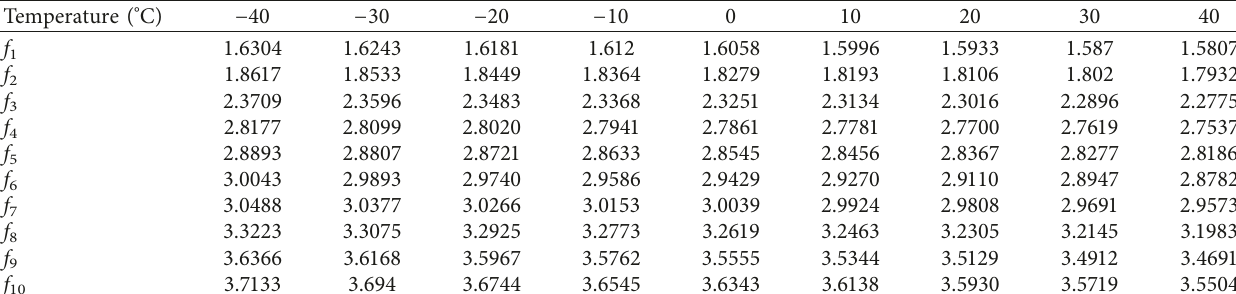
Table 2: Frequencies of the first 10 vibration modes of the CSBV with steel rod cables (unit: Hz). Temperature ( °